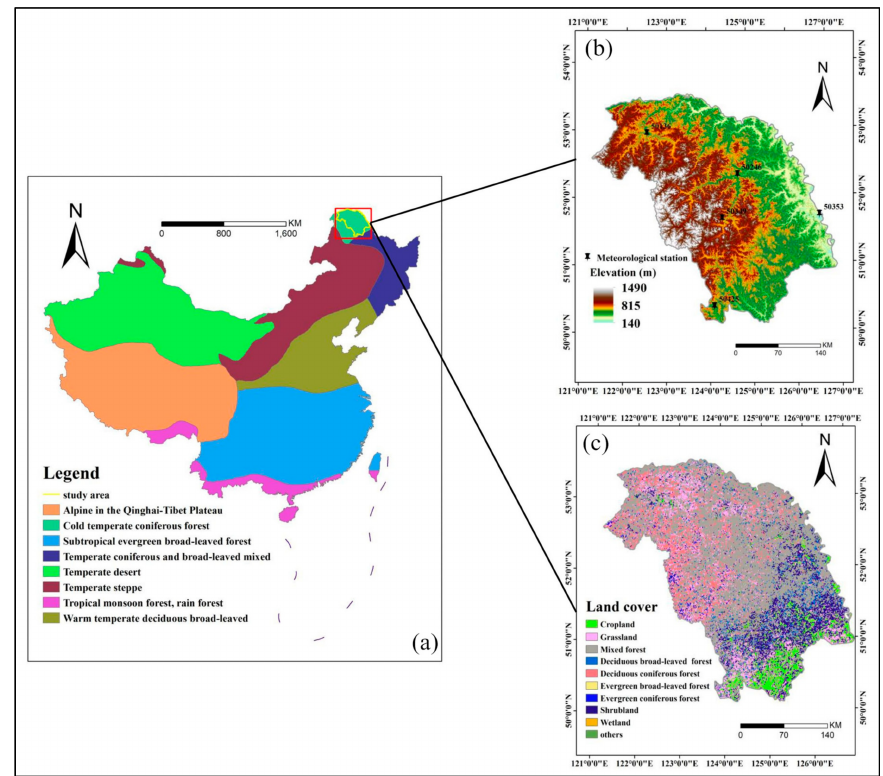
Figure 1. ( a ) Distribution of vegetation type and location of the Greater Khingan Mountains (GKM) in China, based on the Vegetation Regionalization Map of China (1:6,000,000) [47]; ( b ) DEM(Digital Elevation Model) and the meteorological station of the GKM; and, ( c ) Land cover of the GKM. The land cover data is from the MODIS dataset of